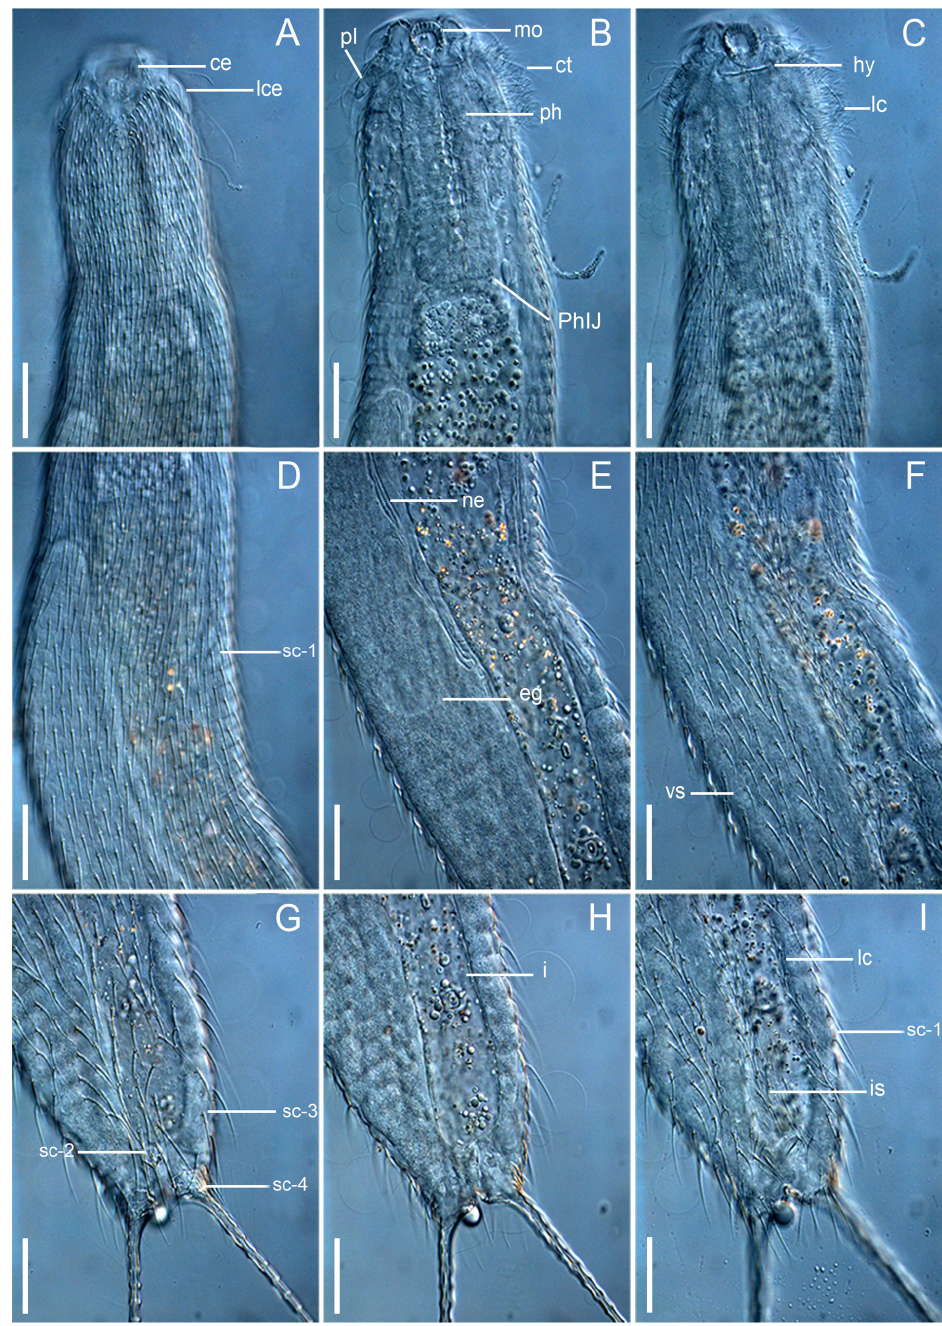
Fig. 3. Light microscopy – DIC. Polymerurus insularis sp. nov., holotype (ZUEC GCH 55). A–C . Correspond to the most anterior third of the specimen. A . Anterior dorsal region. B . Anterior internal region. C . anterior ventral region. D–F . Correspond to the trunk. D . Dorsal trunk. E . Internal trunk. F . Ventral trunk. G–I . Correspond to the posterior third of the specimen. G . Dorsal posterior third. H . Internal posterior third. I . Ventral posterior third. Abbreviations: ce = cephalion; ct = cephalic bristles; eg = egg; hy = hypostomium; i = intestine; is = interciliary spines; lc = locomotory cilia; lce = lateral cephalic expansions; mo = mouth; ne = nephridia; pl = pleurae; ph = pharynx; PhIJ = pharyngeal- intestinal junction; sc-1 = Type 1 scales; sc-2 = Type 2 scale; sc-3 = Type 3 scales; sc-4 = Type 4 scales; vs = Type 1 ventral scale. Scale bars = 20